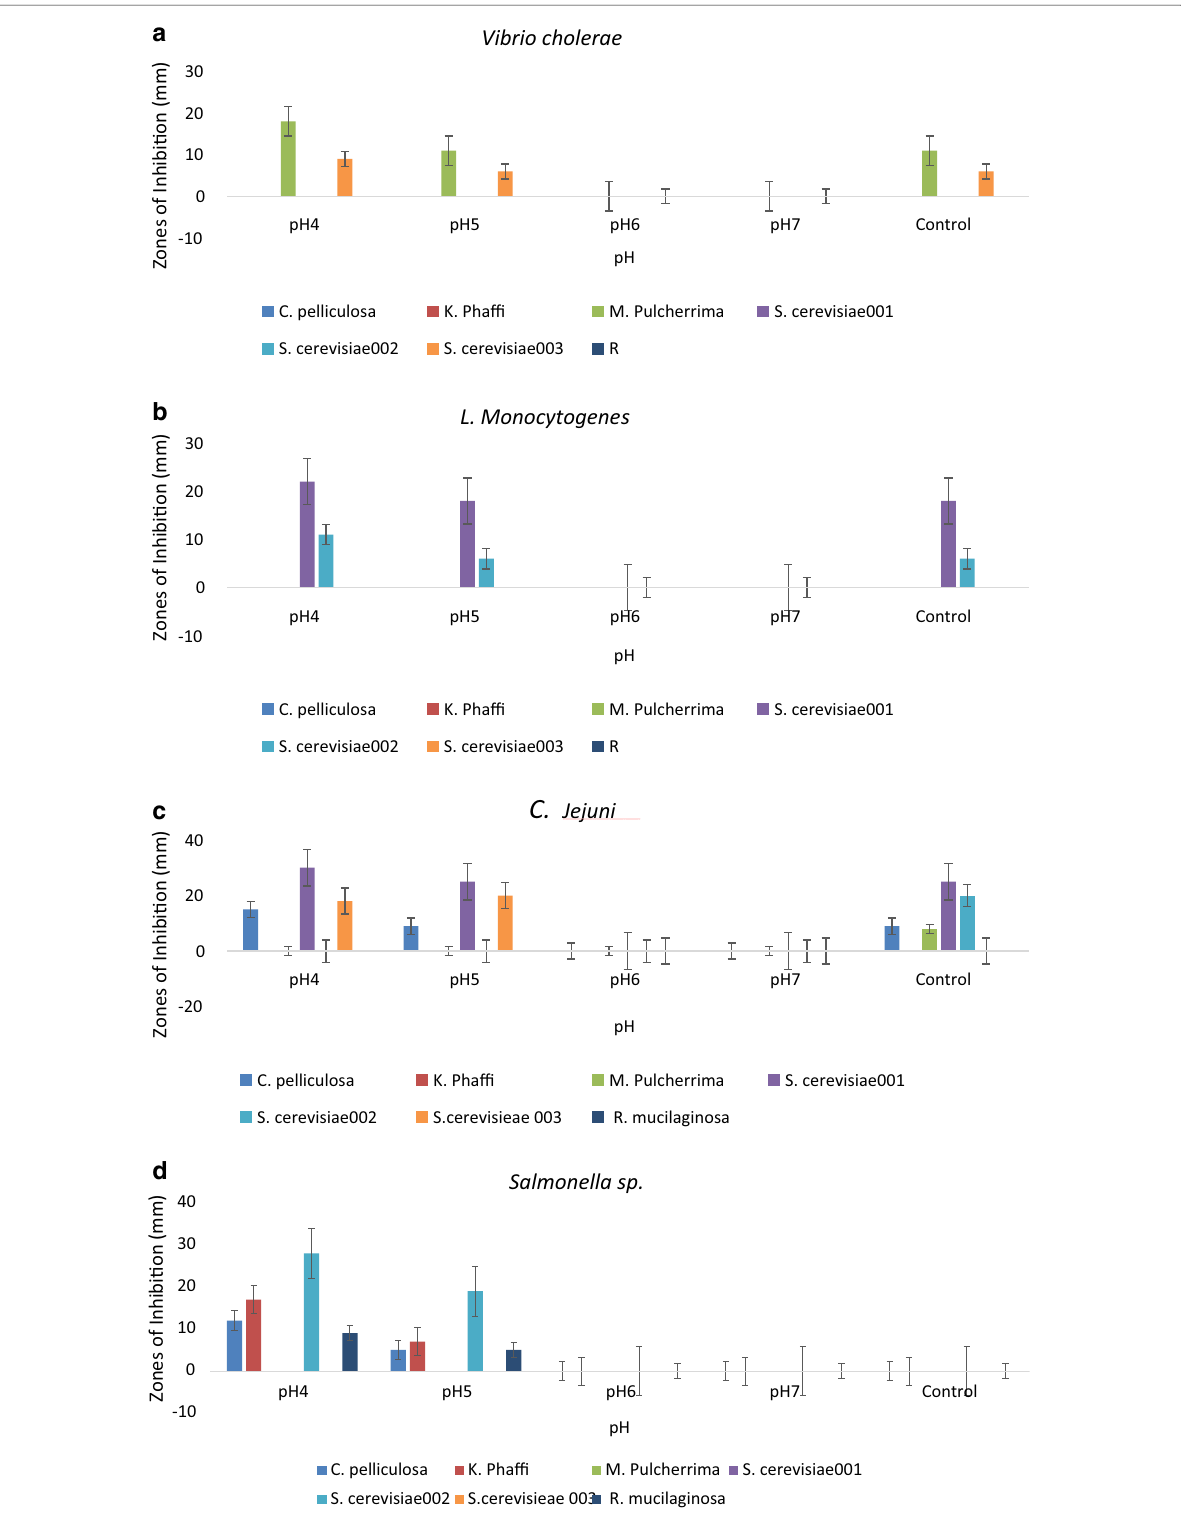
Fig. 3 a Effect of different pH on the antimicrobial activities of the yeast species on Vibrio cholerae. b Effect of different pH on the antimicrobial activities of the yeast species on Listeria monocytogenes. c Effect of different pH on the antimicrobial activities of the yeast species on C. jejuni. d Effect of different pH on the antimicrobial activities of the yeast species on